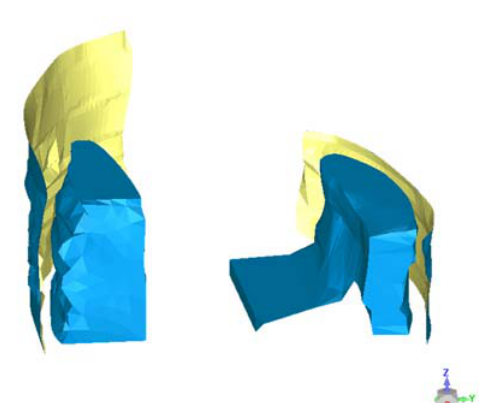
Figure 6: All the digitized 2D sections in plan (a) and in 3D presentation (b) after the assignment of the correct